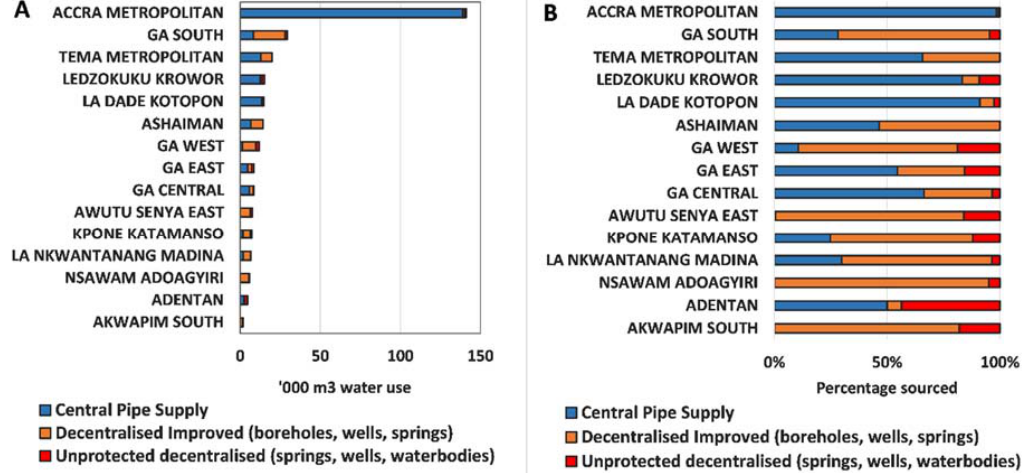
Figure 7. Total domestic water use estimate in GAMA per district for 2010 by supply source. ( A ) Water sourcing in the districts of GAMA by water source type in m 3 . ( B ) The water source types for each district as shares of total water use per district.